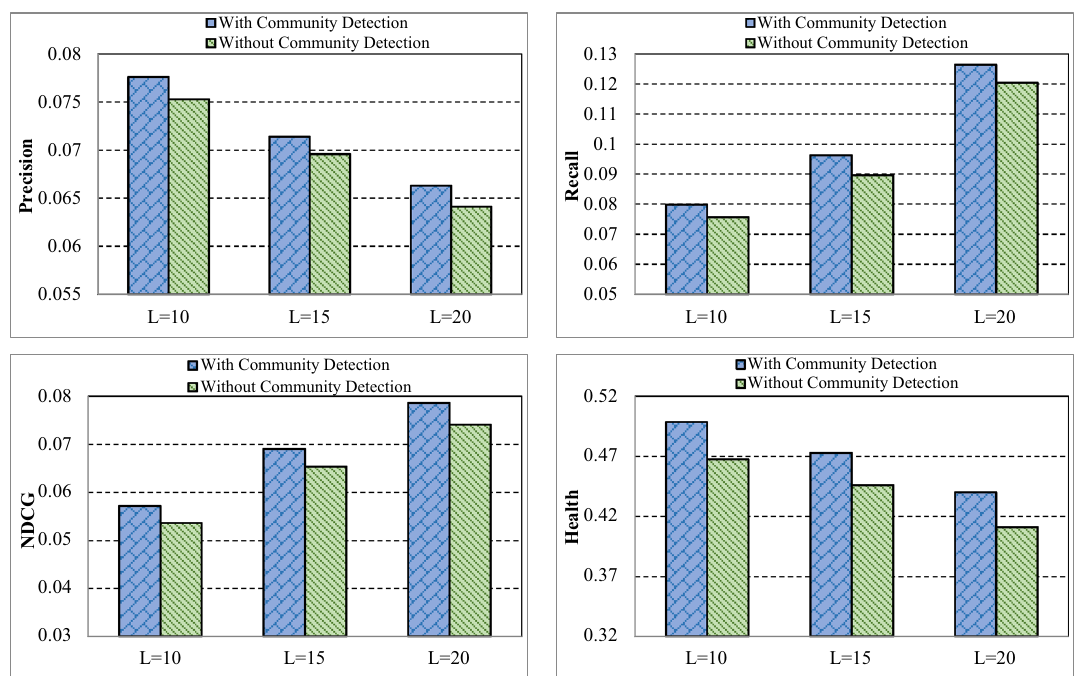
Fig. 8 The comparison of the proposed FRSHR method with the model obtained by ignoring the community detection